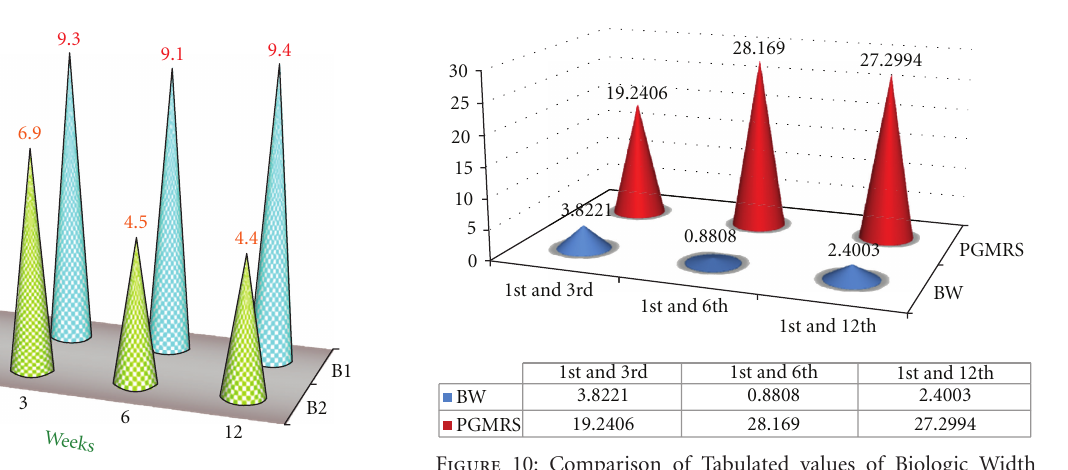
Figure 10: Comparison of Tabulated values of Biologic Width (BW) and Position of GIngival Margin from Reference Stent (PGMRS) with that of Interweek intervals of Group